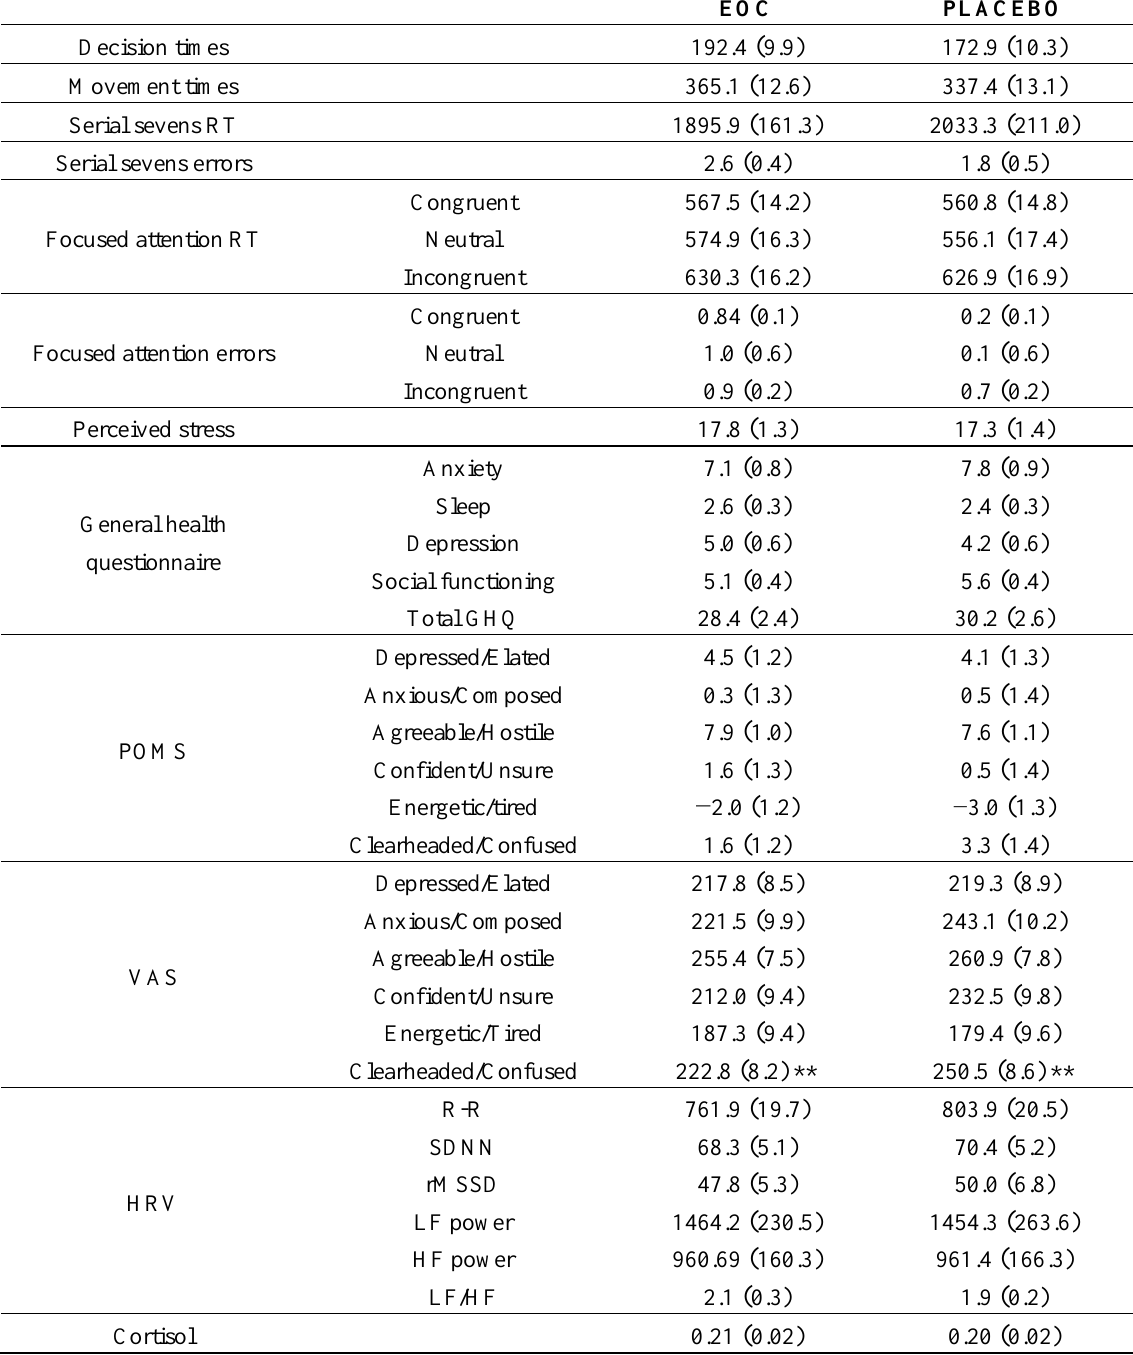
Table 2. Baseline data (mean (SE)) for participants who consumed